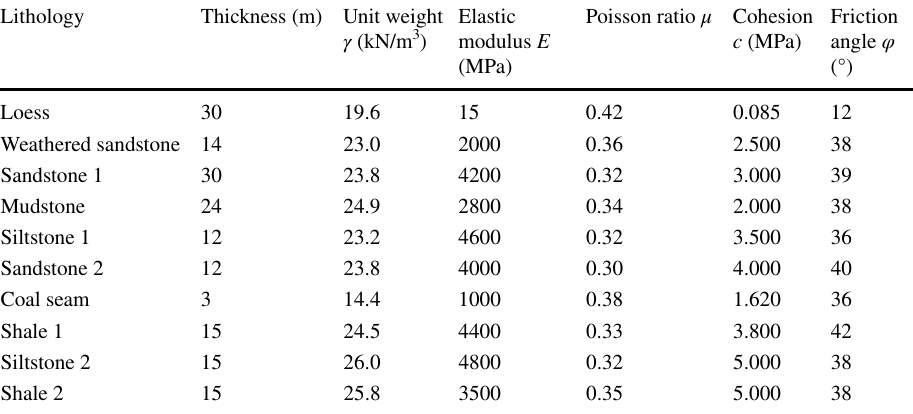
Table 1 Physical and mechanical parameters of coal and rock strata of end slope